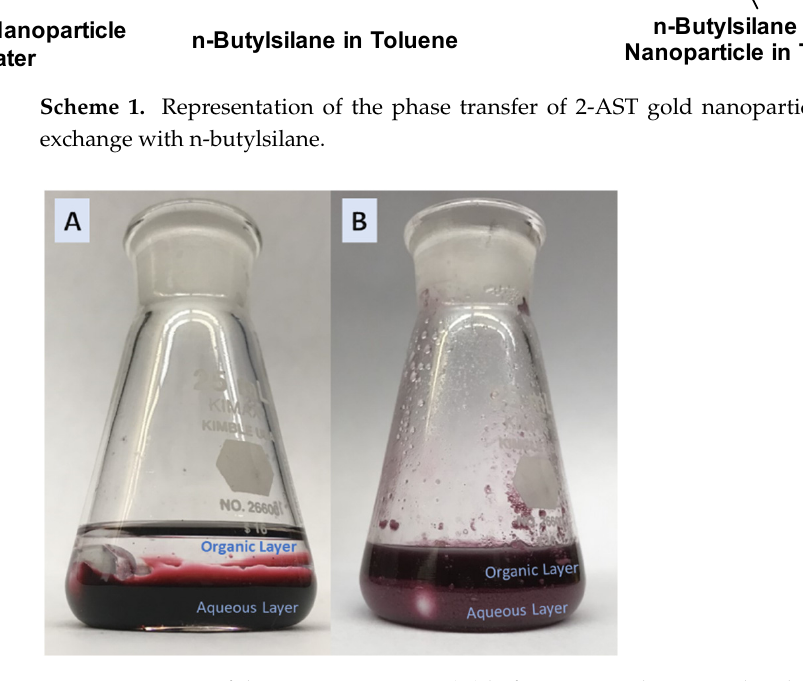
Figure 3. UV-Vis analysis of the nanoparticle-containing toluene layer of the phase transfer reaction mixture at different time intervals. n-Butylsilane was the phase transfer agent.